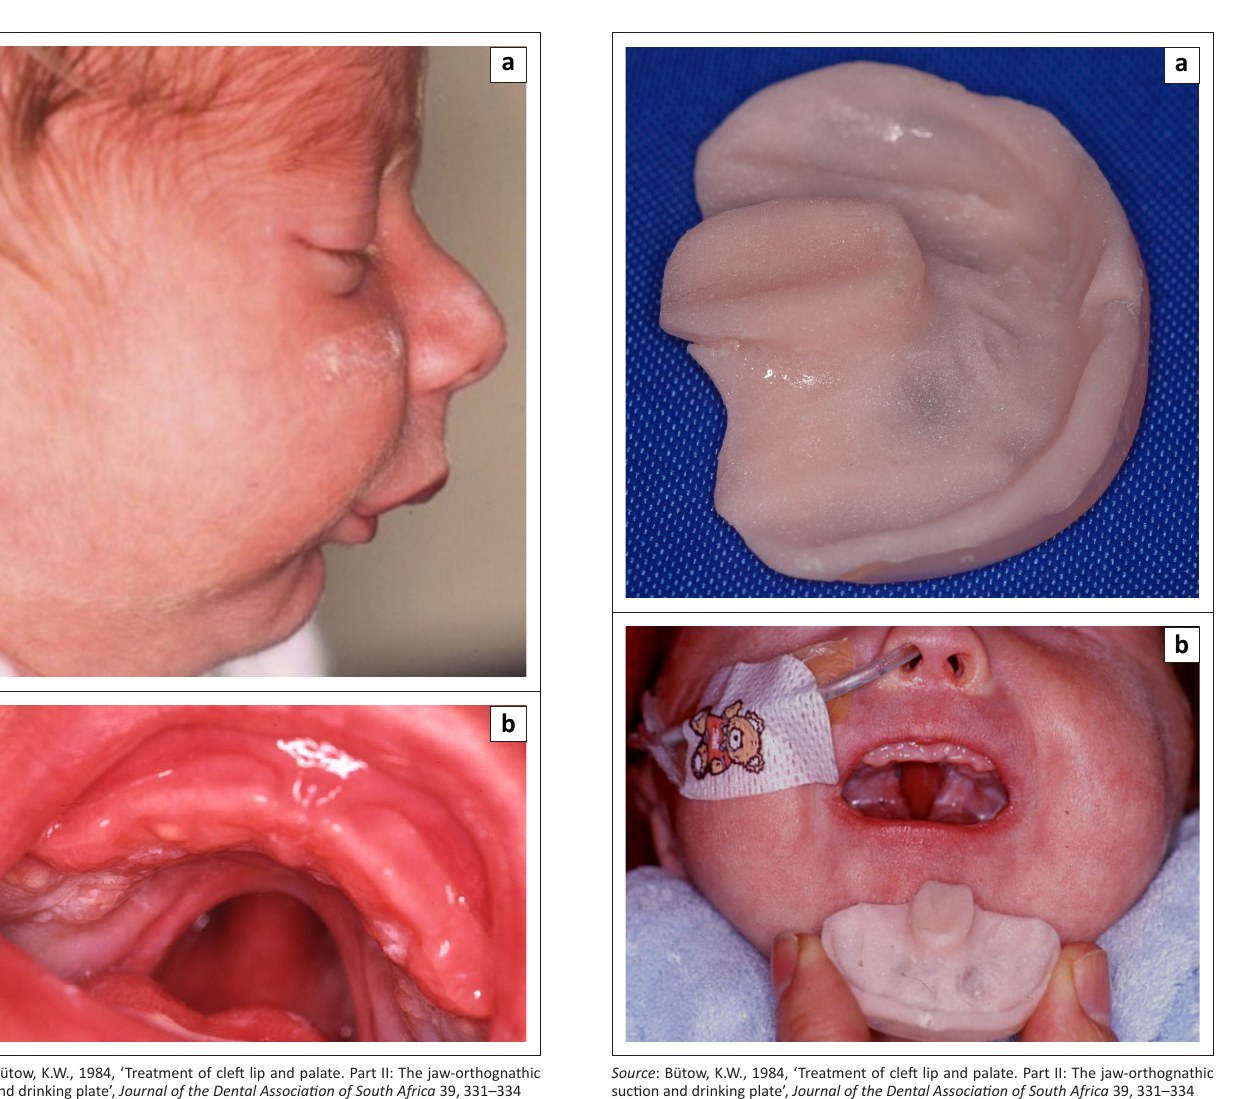
FIGURE 1: (a) Profile of a child with a FRA. (b) Pre-operative appearances of the hard and soft palate